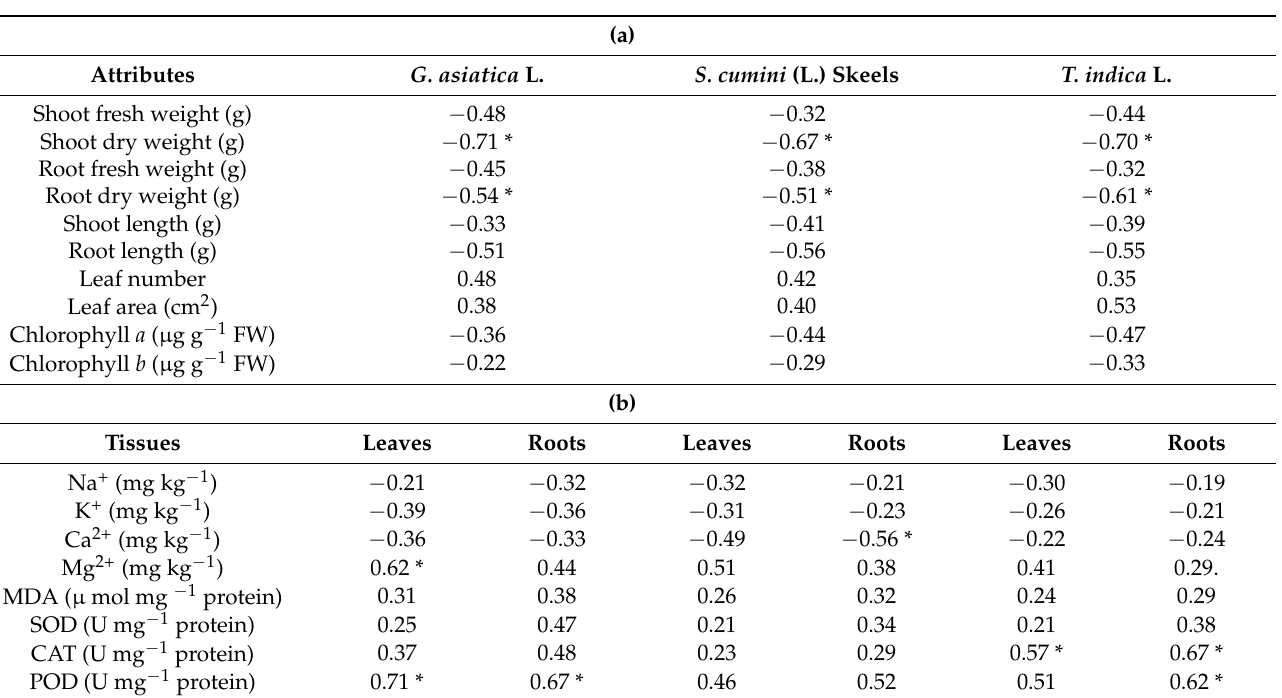
Table 2. Values and significance of correlation coefficient ( r ) by t -test for morpho-biochemical expres- sions, macronutrients, stress marker (MDA), antioxidant enzymes and Ni levels (10–40 µ g kg − 1 ) in tissues (leaves and roots) of three minor fruit species ( Grewia asiatica L., Syzgium cumini (L.) Skeels and Tamarindus indica